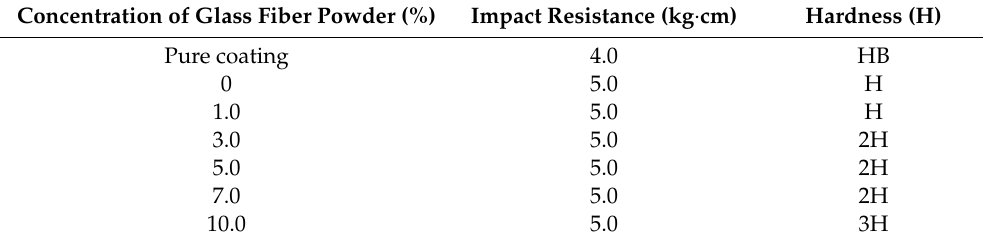
Table 5. E ff ect of glass fiber powder concentration on the impact resistance and hardness of waterborne coatings with thermochromic